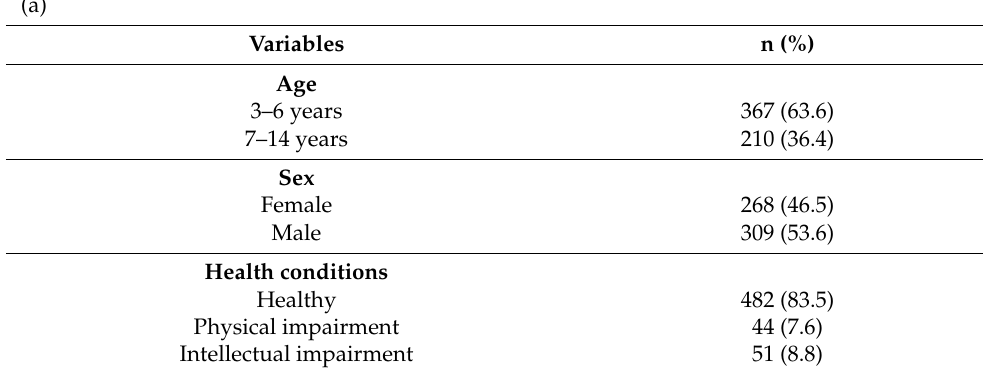
Table 2. Characteristics of the included sample. (a) Demographic data and health conditions, (b) health conditions included intellectual impairment and (c) diseases not involving the intellec- tual